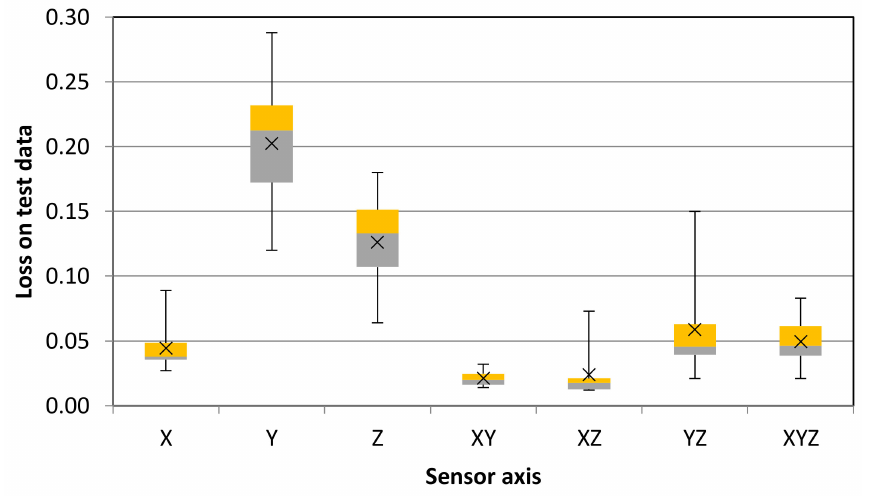
Figure 24. Box plot of ‘loss on test data’ for all sensor axis of the